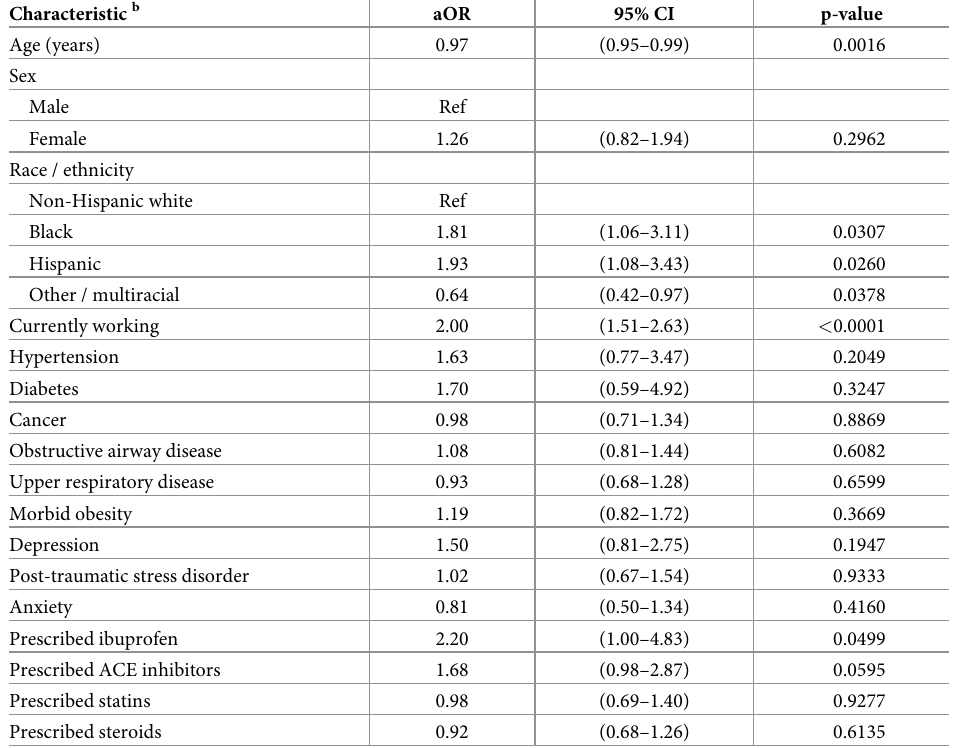
Table 3. Multivariable logistic regression: Correlates of confirmed SARS-CoV-2 infection among World Trade Center responders with known COVID-19 status (event N/total N: 385/1,202) a